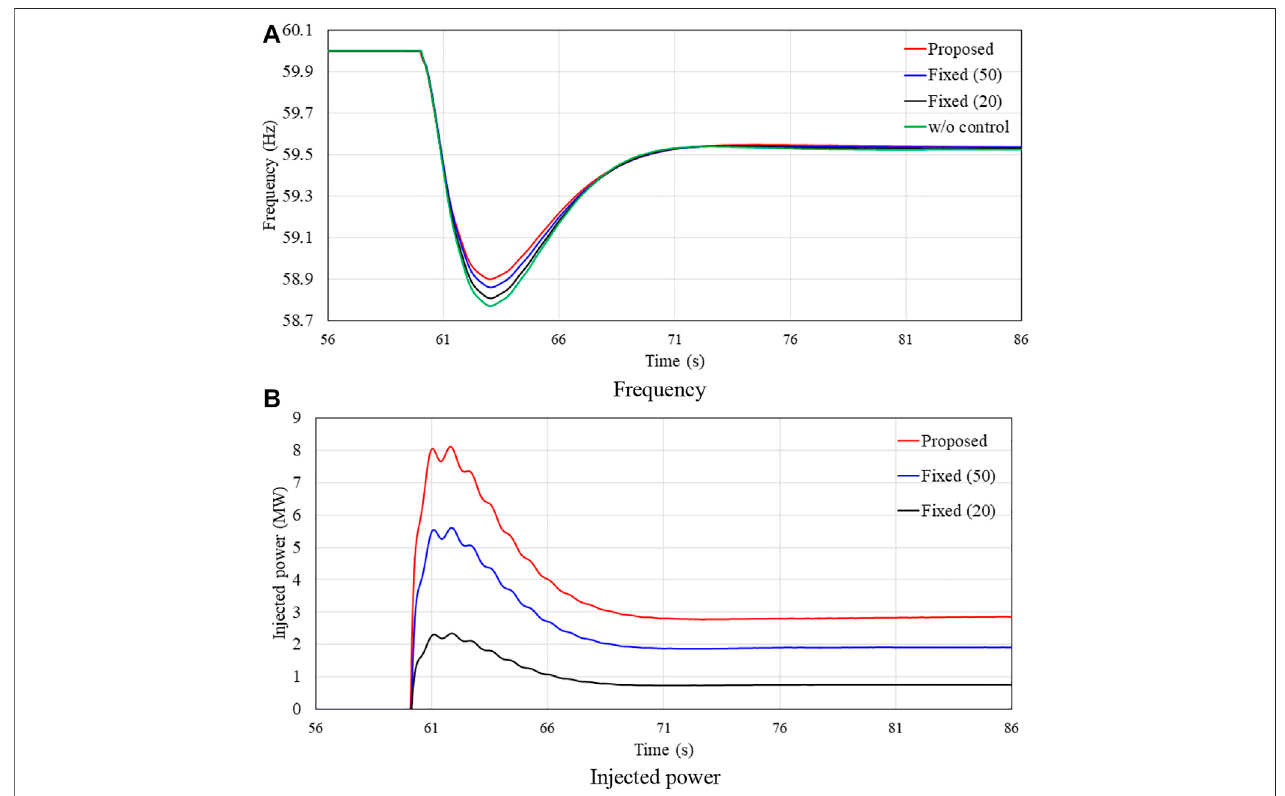
FIGURE 9 | Results for case 3 with severe disturbance. (A) Frequency. (B) Injected